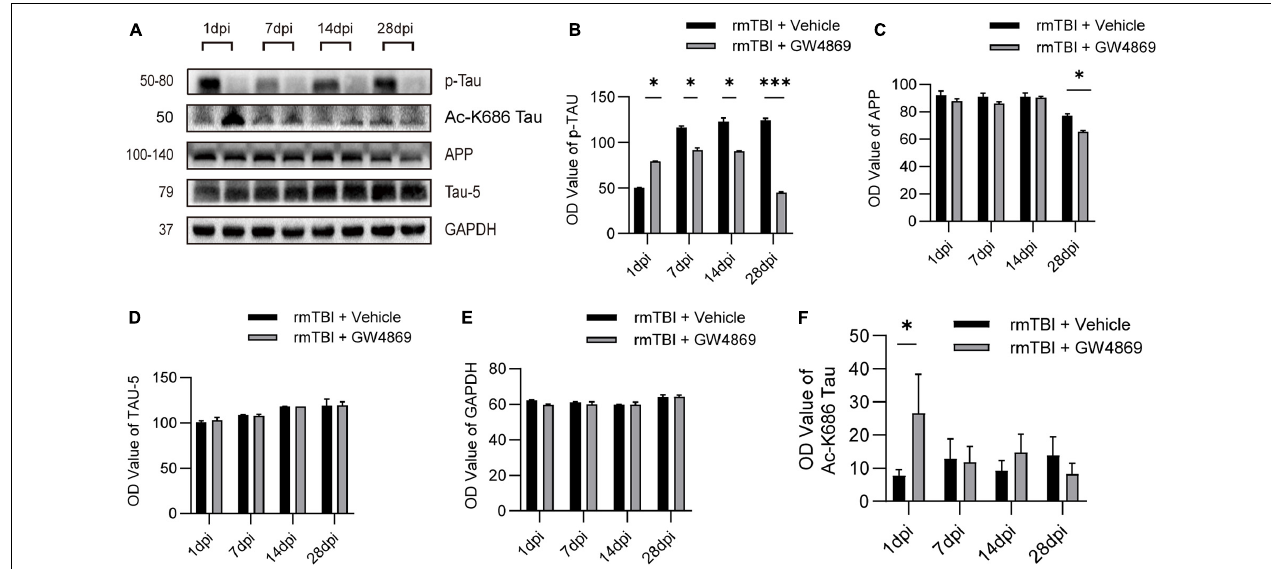
FIGURE 4 | (A) Western blotting analysis of the expression of the neuropathological proteins APP, A β 1-42, and p-Tau at 1, 7, 14, and 28 dpi in the brains of mice with rmTBI treated with GW4869 or Vehicle control. (B) Bar graph showing persistently lower levels of p-TAU in the rmTBI + GW4869 group versus the rmTBI + Vehicle group. The level of A β 1-42 (C) decreased in the mice with rmTBI treated with GW4869 from 14 to 28 dpi after rmTBI. The level of APP (D) decreased in the mice with rmTBI treated with GW4869 at 28 dpi. (E) Bar graph showing that the expression of GAPDH remained unchanged. (F) Bar graph showing that compared with the rmTBI + Vehicle group, the acetylated-tau of the rmTBI + GW4869 group has a significant increase at 1dpi, but there is no significant change at 7, 14, and 28dpi. Mean ± SD. n = 5 mice per group. ∗ p < 0.05, ∗∗∗ p <